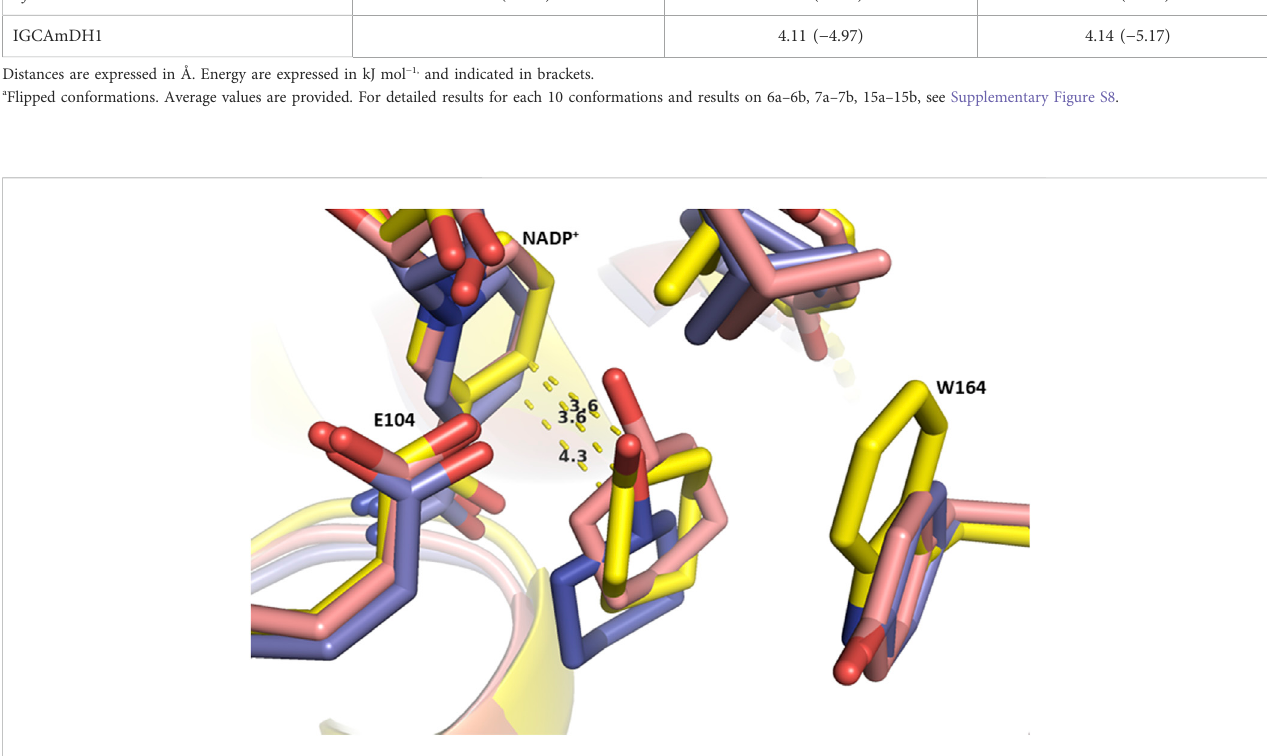
FIGURE 4 C4N-C(OH) distances for Msme AmDH (yellow), Cfus AmDH (pink) and IGCAMDH1 (purple) with selected conformations of docked cyclohexanol (15c). Distances are in Å. Surrounding residues are labelled only for Msme AmDH for